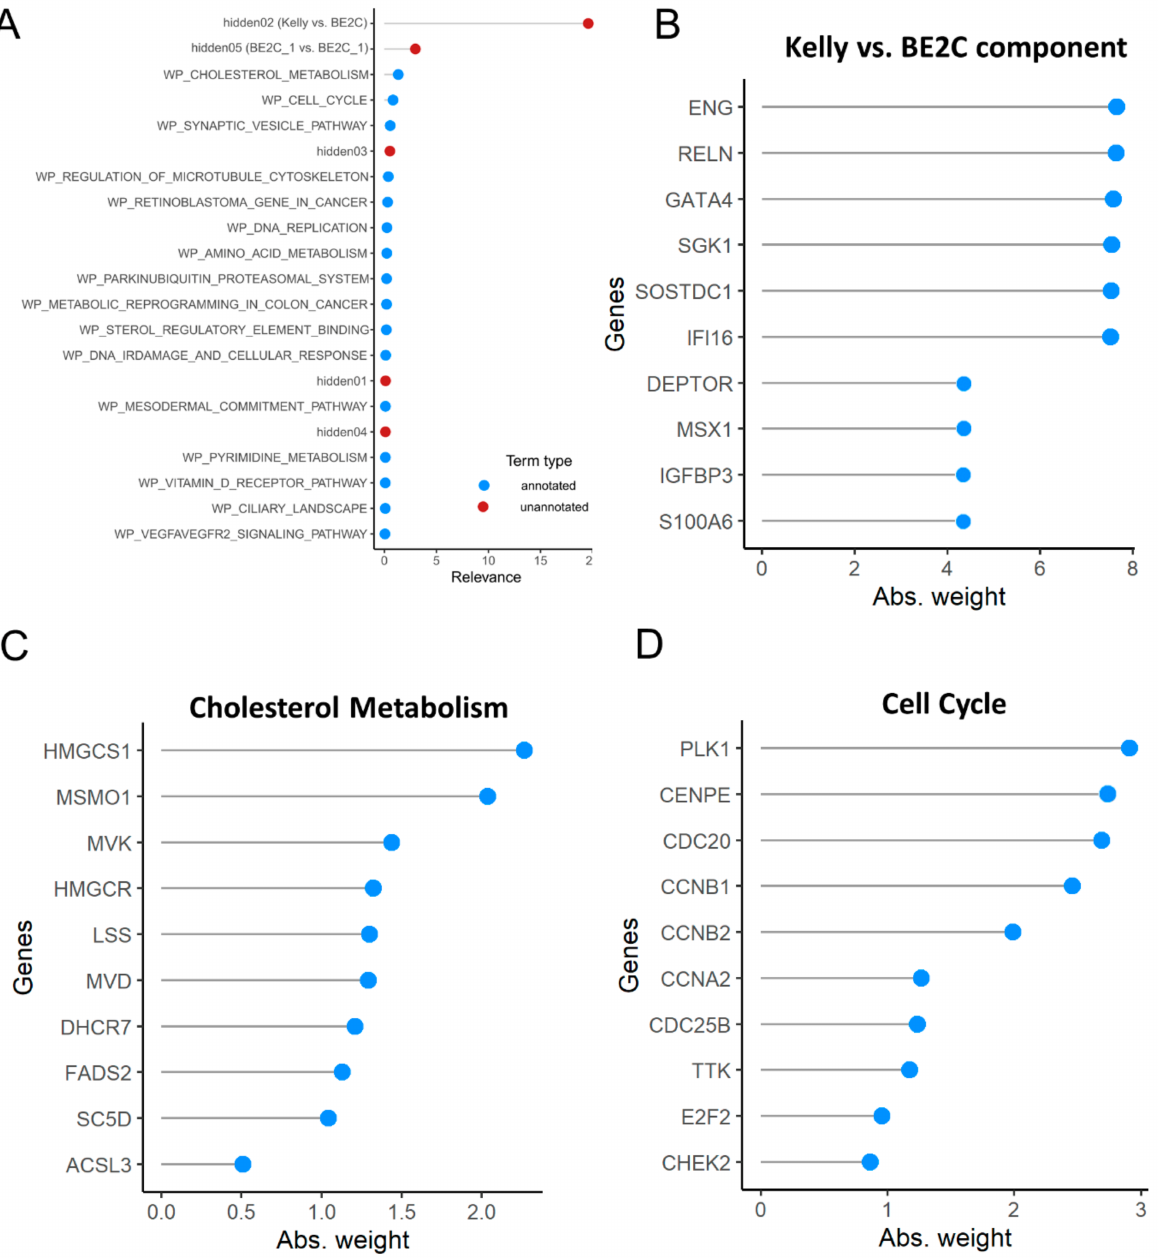
Figure 8. Dissection of heterogeneity in the single-cell dataset, according to the f-scLVM algorithm [69] based on known pathway annotations available from Wiki Pathways [70] and MsigDB [37]. ( A ) Graph showing the most relevant factors identified by the f-scLVM model, both annotated in Wiki Pathways (blue) or not annotated (red). ( B – D ) Loadings of the most influential genes in ( B ) “hidden02, Kelly vs. BE2C”, ( C ) “cholesterol metabolism” and ( D ) “cell cycle” terms, defined by the Absolute Weight parameter of the f-scLVM